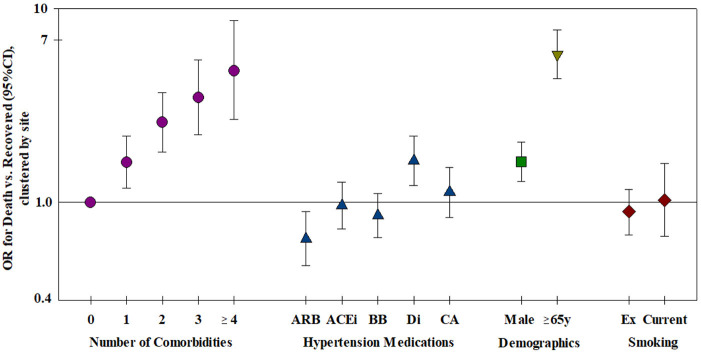
Risk factors for mortality—all risk factors were included in the model, clustered by site (n = 2,868). ARB, Angiotensin receptor blocker; ACEi, Angiotensin converting enzyme inhibitor; BB, Beta-blocker; Di, Diuretic; CA, Ca-antagonist.